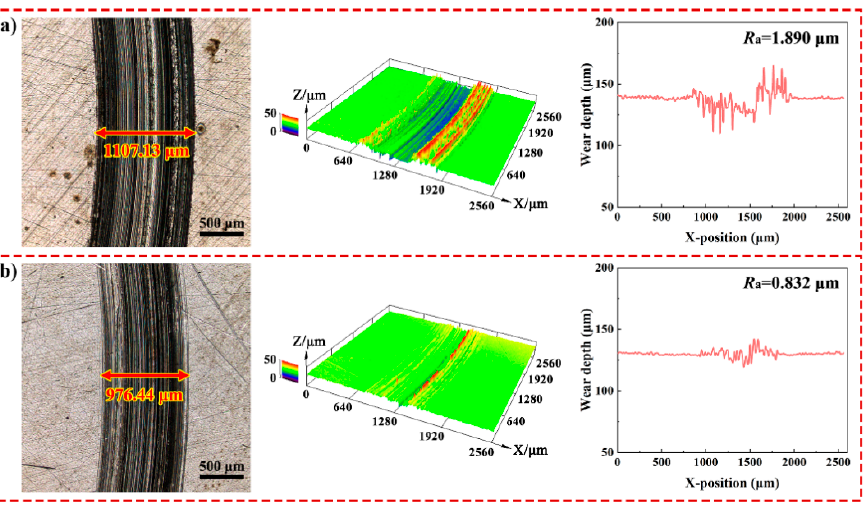
Figure 7. Tribological behavior of base fluid and rGO-Al 2 O 3 nanofluid: ( a ) friction coefficient–time curves and ( b ) wear rate and average friction coefficient.